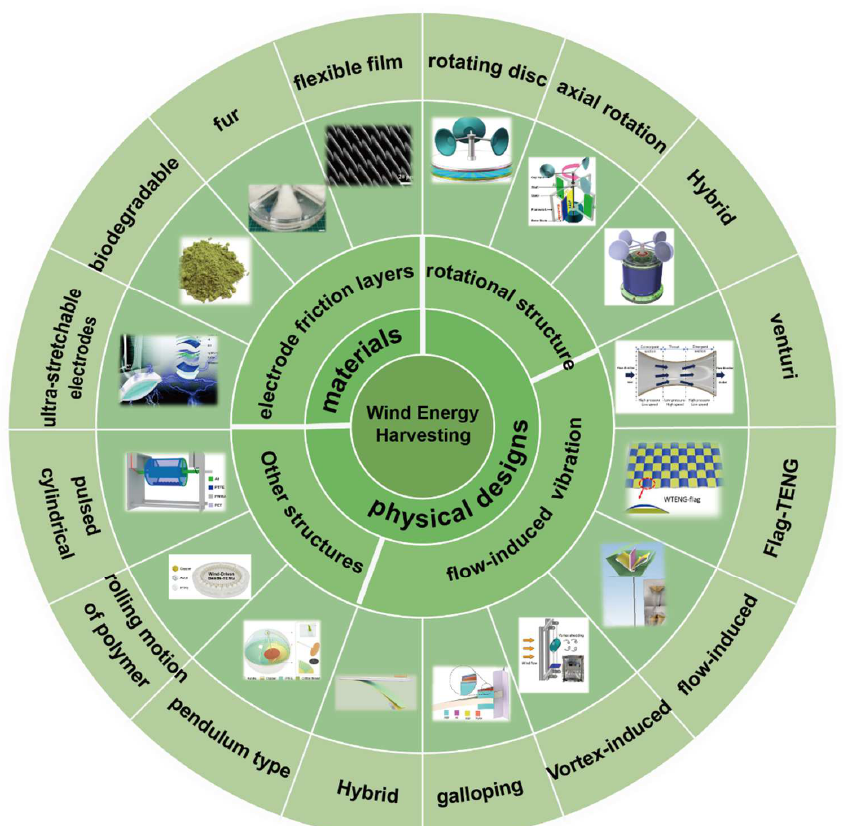
Figure 1. Overview of common materials and structures for WD-TENGs. Rotating disc. Reproduced